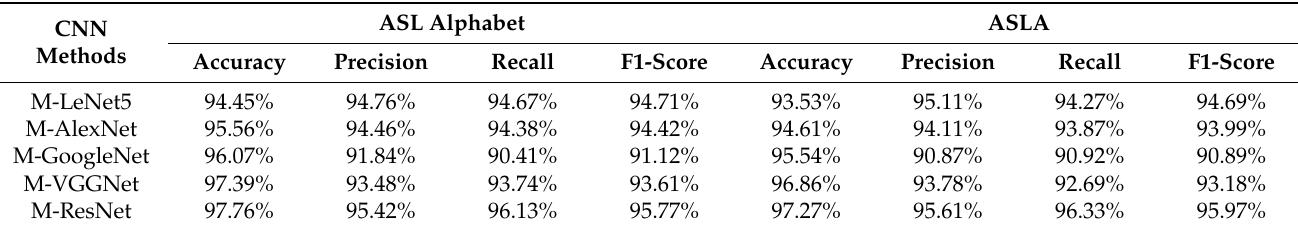
Table 6. Performance evaluation of the five CNNs on both datasets.